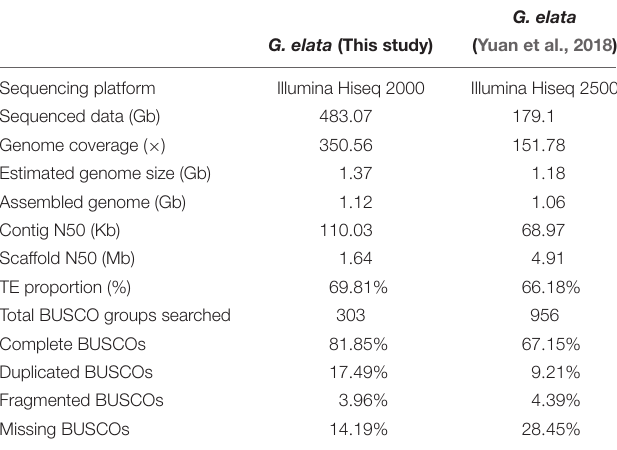
TABLE 1 | Various assembly parameters of the G. elata genome.